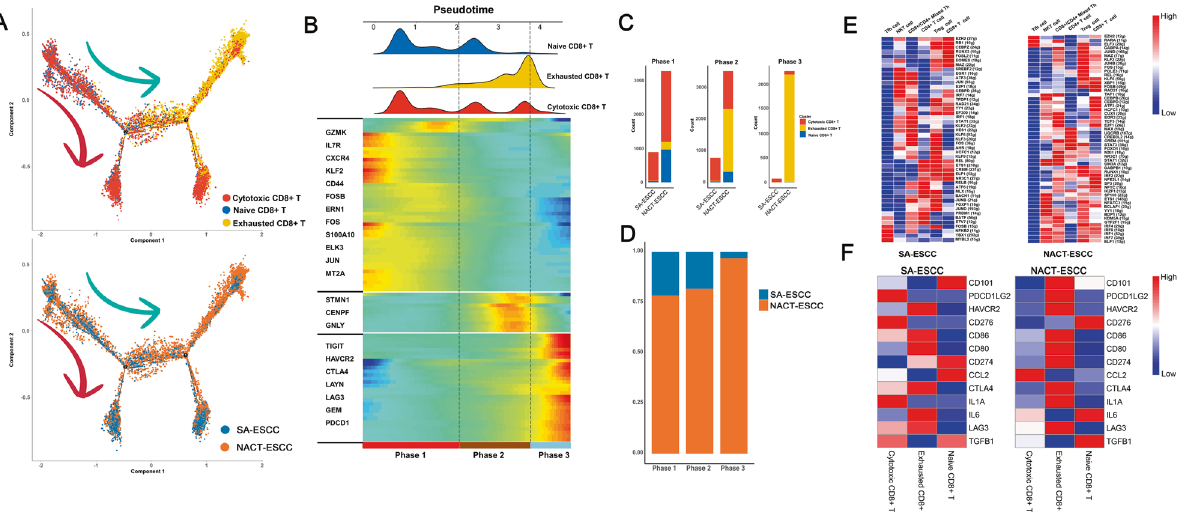
Fig. 8 The scRNA Pro fi les for CD8 + T cells in SA-ESCC and NACT-ESCC. A Potential developmental trajectory of CD8 + T cells inferred by analysis with Monocle2. B Dynamic changes in gene expression of CD8 + T cells during the transition (divided into 3 phases), subtypes are labeled by colors (upper panel). C Histogram showing the cell distribution of CD8 + T cells, in SA-ESCC and NACT-ESCC samples. CD8 subtypes labeled by colors. D Histogram showing the cell distribution of SA-ESCC and NACT-ESCC samples. E Heatmap showing the activity of TFs in each CD8 + T cell subtypes in each condition. The TF activity is scored using AUCell. Left, SA-ESCC. Right, NACT-ESCC. F Heatmap showing the activity of immune checkpoints in each T cell subtypes in each condition. Left, SA-ESCC. Right,